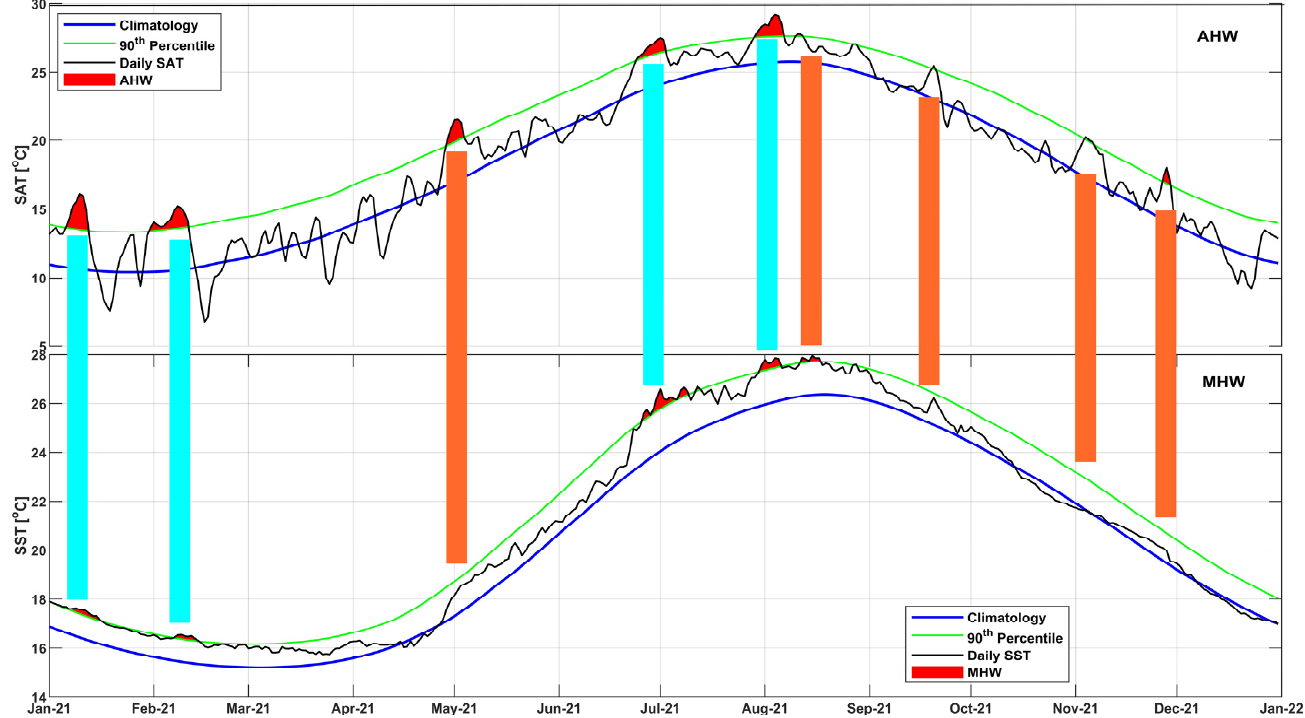
Figure 9. The 2021 co-occurrence of AHW ( upper panel ) and MHW ( lower panel ) events; the red shaded areas refer to the AHW/MHW events. The black solid line de fi nes the SAT/SST (°C), the blue solid lines indicate the SAT/SST (°C) climatology, and the green solid lines denote the 90th percentile for SAT/SST (°C). The cyan and orange bars indicate the co-occurrence and stand-alone events, re- spectively.